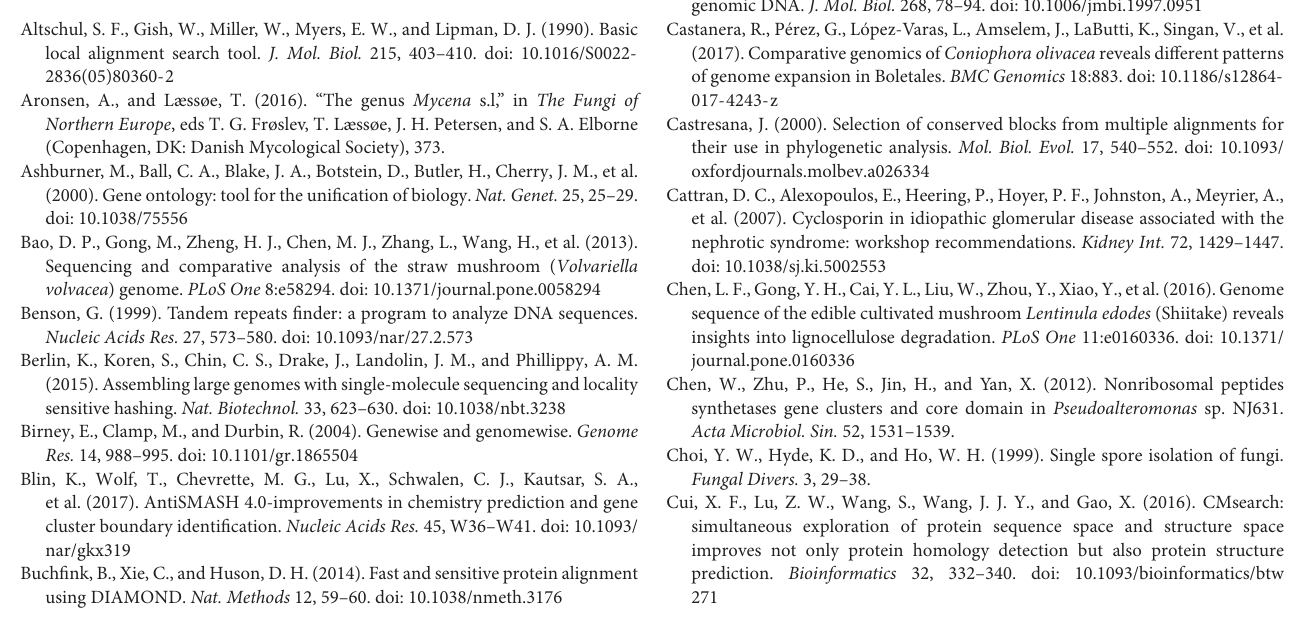
Supplementary Table 1 | Summary of fungi analyzed in this study and origin of their genomes. Supplementary Table 2 | Genes predicted to be involved in non-coding RNA in Sarcomyxa edulis . Supplementary Table 3 | Sarcomyxa edulis gene annotations. Supplementary Table 4 | Putative CYP gene families of Sarcomyxa edulis .